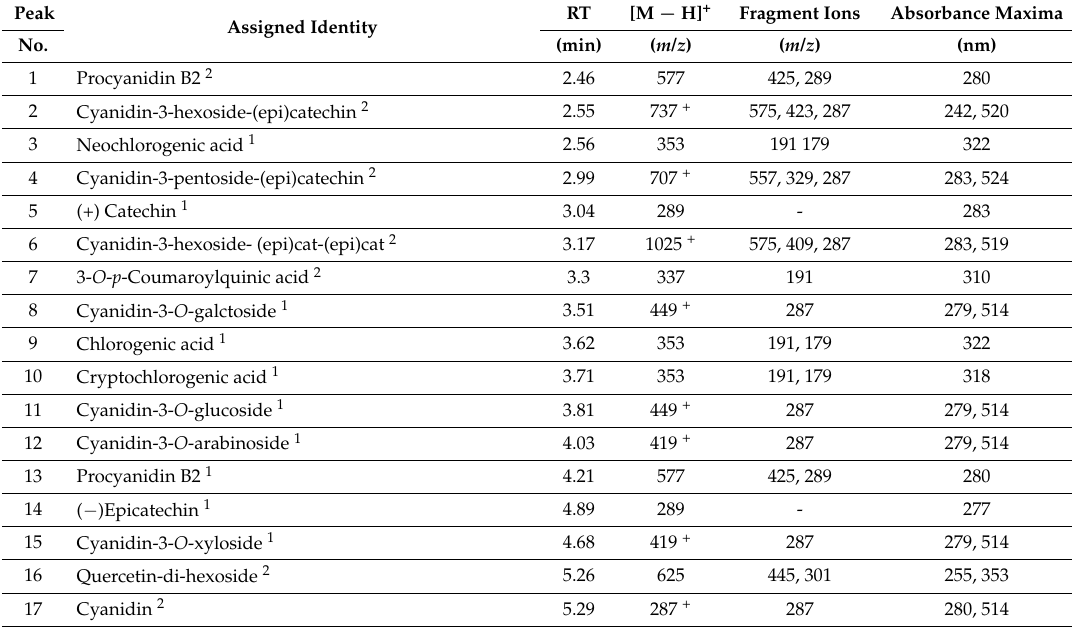
Table 2. Identification of phenolic compounds in black chokeberry ( Aronia melanocarpa L.) fruits by ultra-performance liquid chromatography and photodiode detector-quadrupole/time-of-flight mass spectrometry